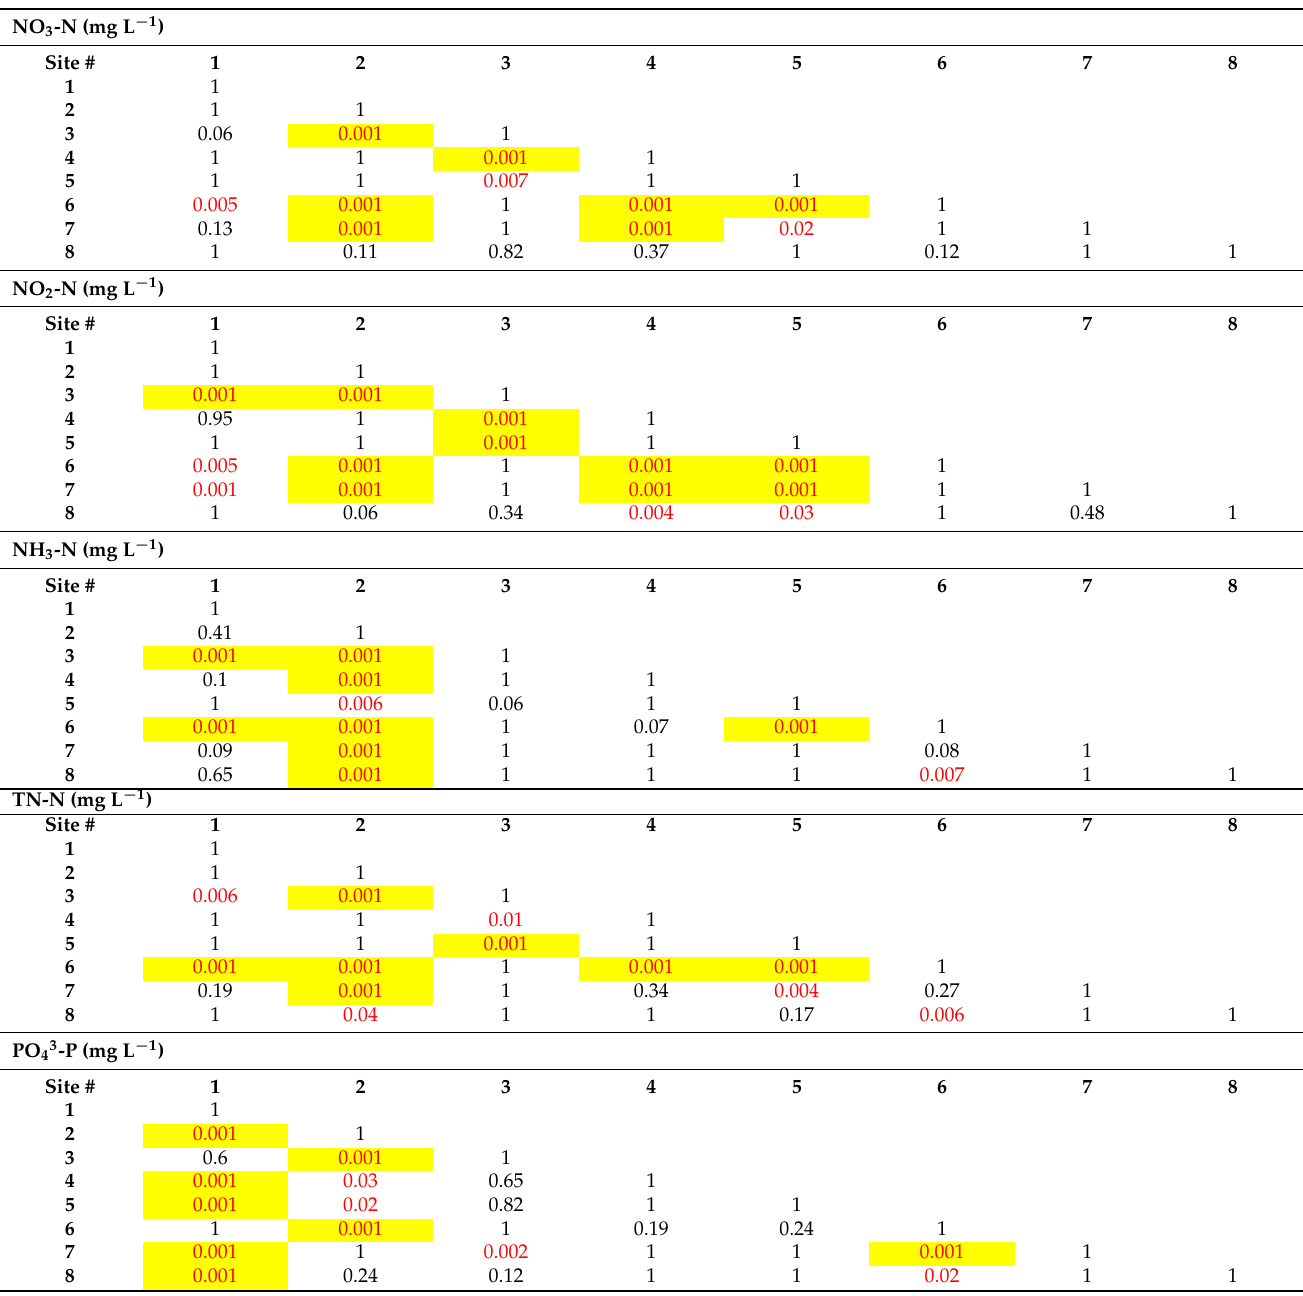
Table A2. Results of inter-site comparisons, via Friedman’s ANOVA and Dunn’s post hoc multiple comparison tests, for significant differences ( CI = 95%) between shallow groundwater